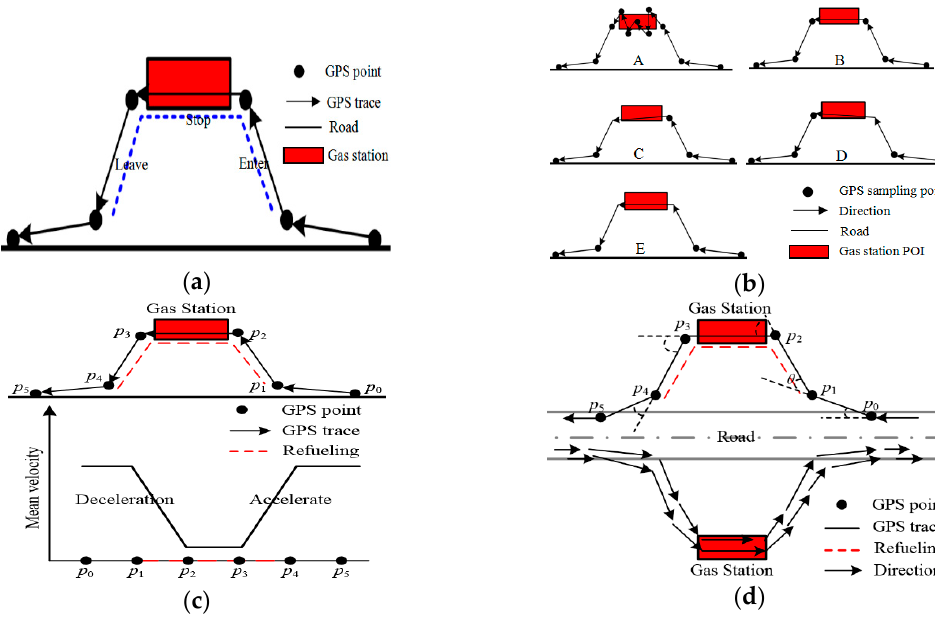
Figure 2. Analysis of trajectory features of an individual refueling stop track. ( a ) Refueling stop track of individual vehicle; ( b ) Stop/Move pattern of refueling stops; ( c ) Average velocity and velocity change; ( d ) Direction and direction change.